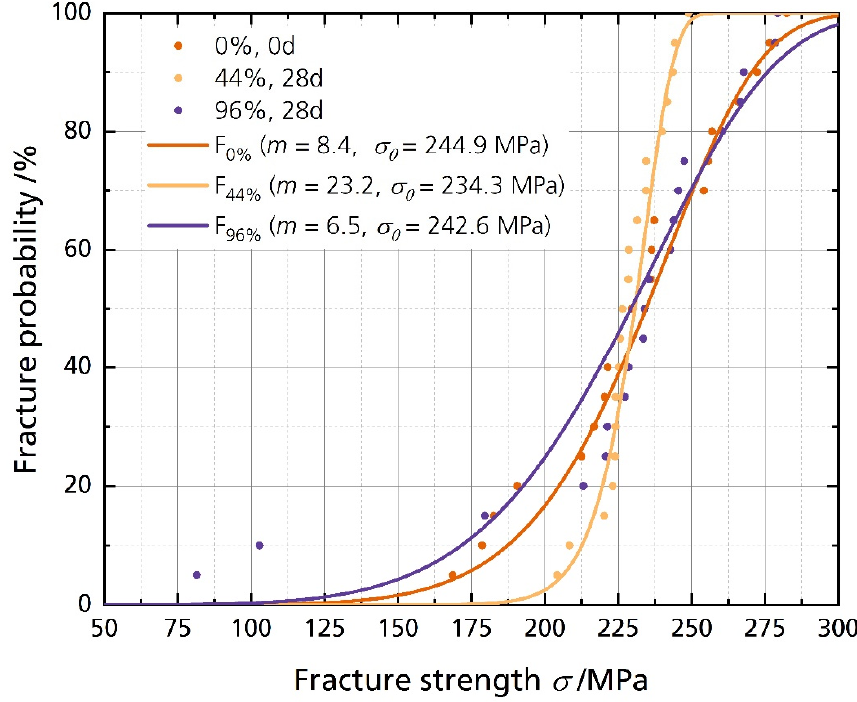
Figure 6. Weibull plot of the fracture strength analysis with their corresponding cumulative distri- bution functions (cdf), calculated with F( σ , m , σ 0 ) = 1 − exp( −σ / σ 0 ) m ). Table 2. Characteristic strengths σ 0 and σ 0 . 001 , Weibull moduli m , average fracture strengths σ avg and the fracture strengths’ corresponding standard deviation σ σ of the pristine sample and the samples stored for 28 days in 44% r.h. and 96% r.h.